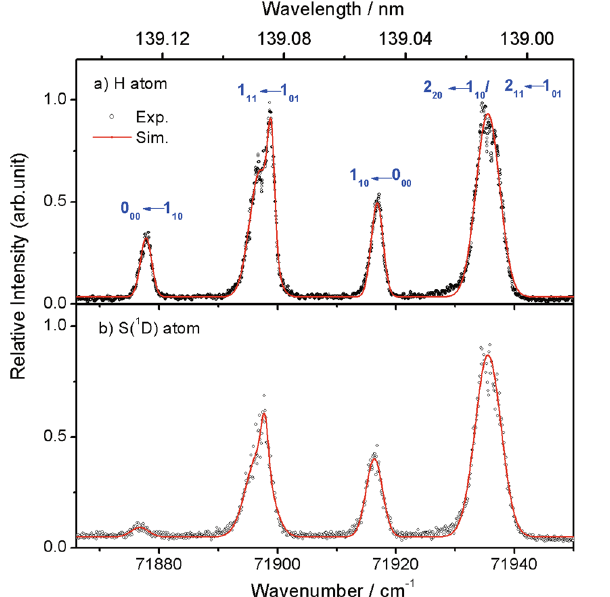
Fig. 2 The H and S( 1 D) product photofragment excitation (PHOFEX) spectra following photoexcitation of H 2 S. a H and b S( 1 D) atom PHOFEX spectra obtained following photodissociation of a jet-cooled 30% H 2 S in Ar sample at wavelengths in the range 139.13 ≥ λ ≥ 138.99 nm (71,875 – 71,950 cm − 1 ), with the dominant transitions contributing to the four features indicated. The raw data are provided as a Source Data fi